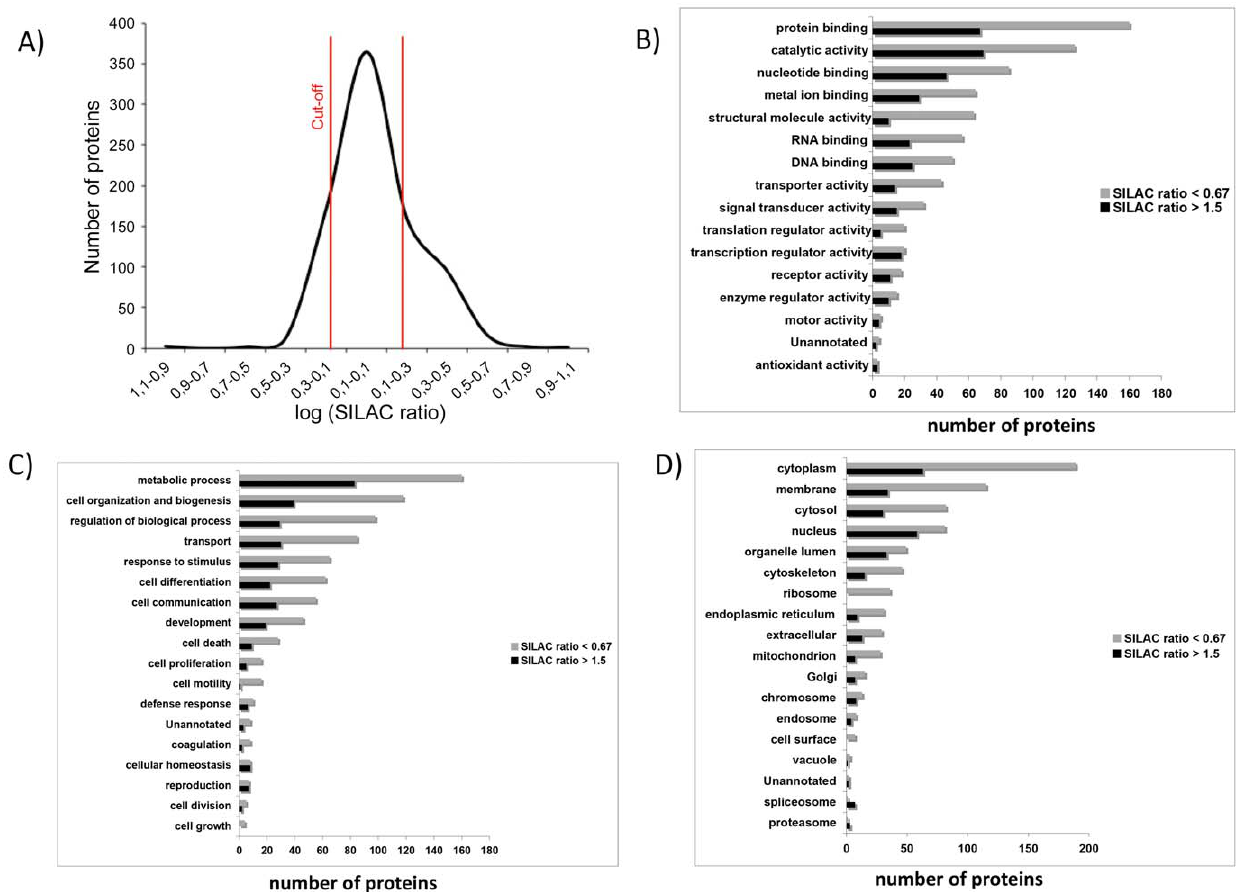
Figure 2. A) Distribution of SILAC T24T/T24 ratios: The log of the SILAC ratio for each protein ( n =2) represents the difference in relative expression between highly metastatic (T24T) and invasive (T24) bladder cancer cells. Proteins were sorted and plotted by SILAC ratio. As expected for a 1:1 mixture, most proteins showed a SILAC ratio within the 1.5 and 0.67 cutoffs. Classification of the proteins identified based on their functional annotations using the Gene Ontology: B ) Molecular function, C ) Biological processes and D ) Cellular components. These